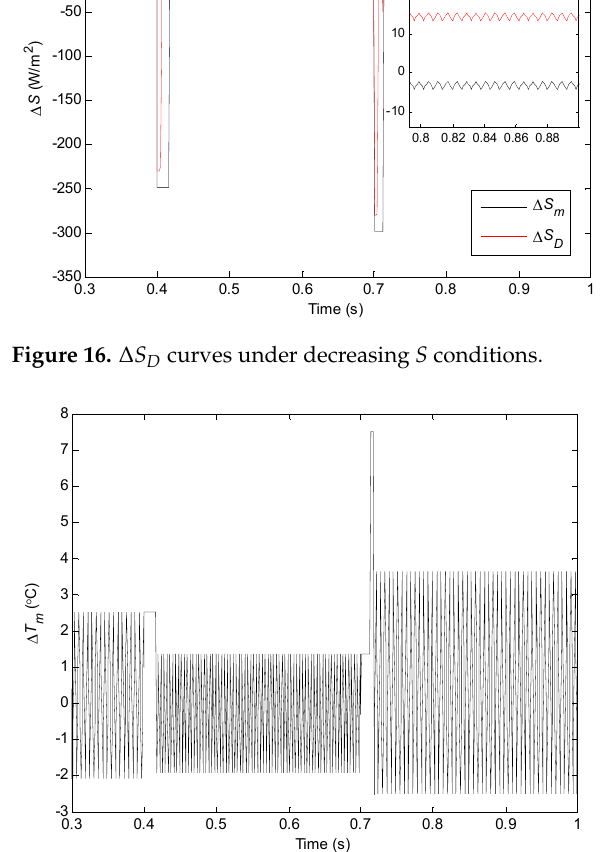
Figure 17. Curves under decreasing S conditions.